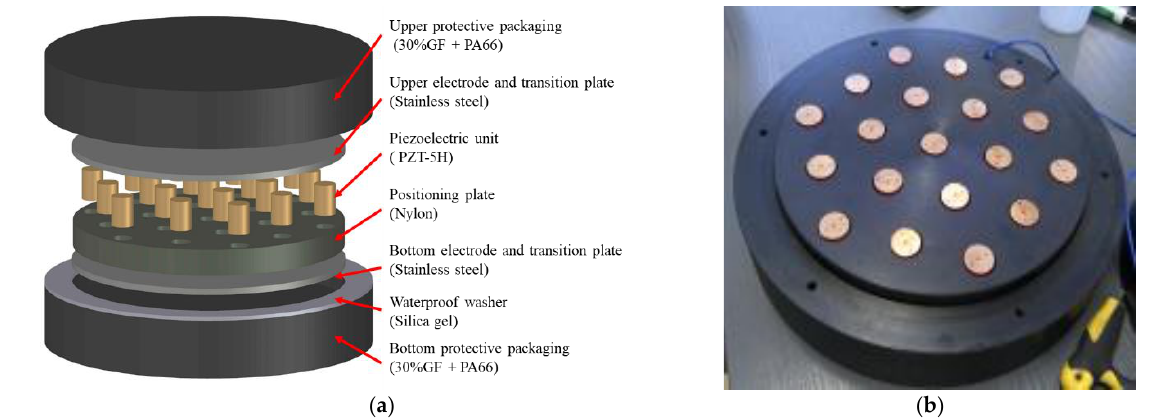
Figure 5. Structure of the PEH. ( a ) Diagram of the PEH. ( b ) Arrangement of piezoelectric units in the PEH. Different numbers of piezoelectric units ranging from eight to 15 were placed in the PEH and the sinusoidal load was applied by the Cooper HYD 25-II machine. The oscillo- scope and charge amplifier were used to monitor the voltage and charge signals, and the influence of the number of units on the power generation performance was analyzed.